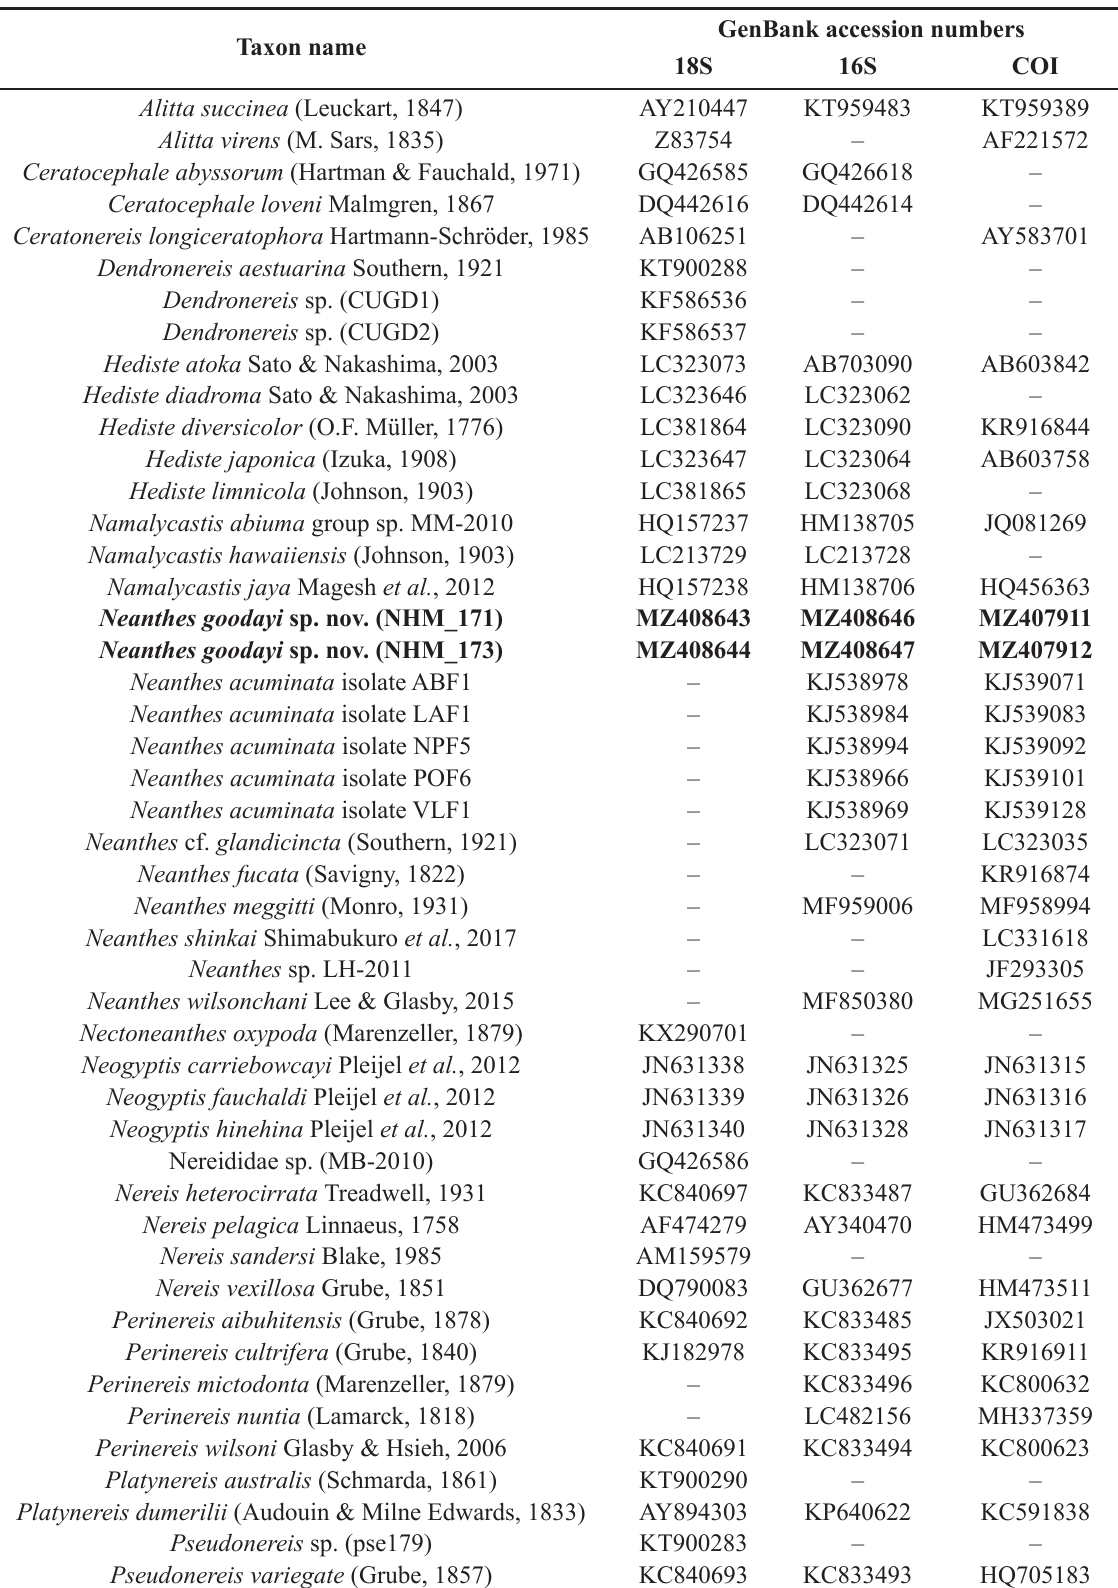
Table 1. List of taxa used in phylogenetic analyses with respective NCBI GenBank accession